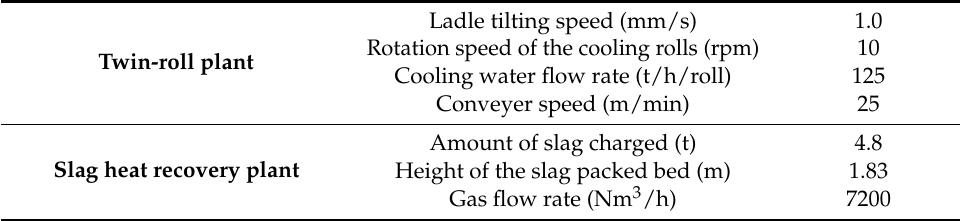
Table 4. Operating conditions of pilot-scale slag heat recovery test.